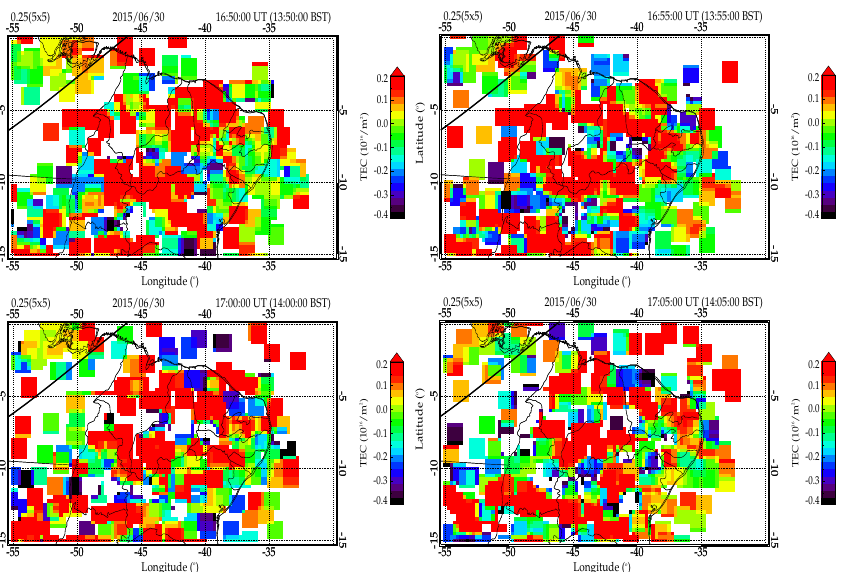
Figure 4. The series of dTEC maps on 30 June 2015 from 16:50:00 UT (13:50:00 LT) to 17:05:00 UT (14:05:00 LT) in every 5 min time